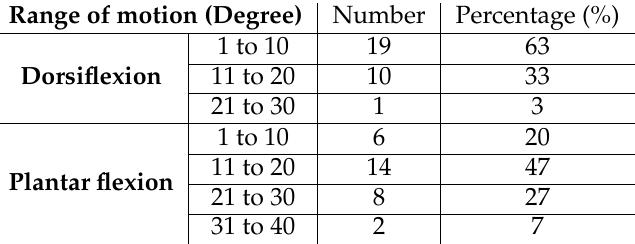
Table 4. Distribution of study subjects according to range of motion (Degree) Range of motion